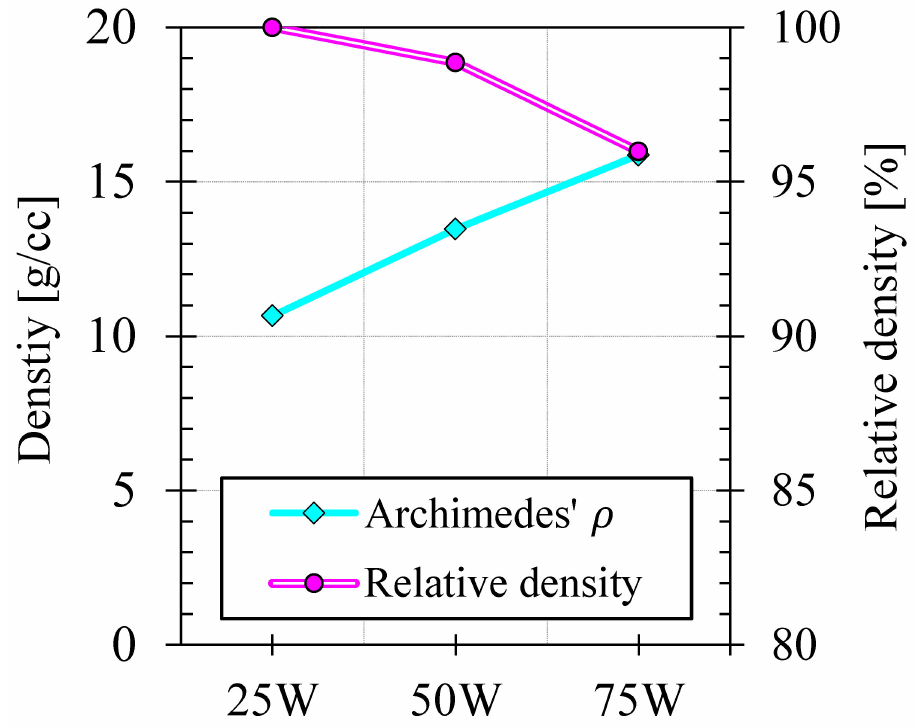
Figure 9. Archimedes’ density and the corresponding relative